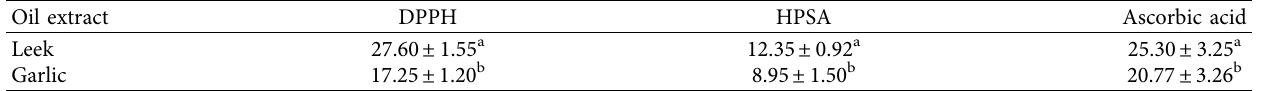
Table 2: Antioxidant activities of garlic bulbs and leek leaf